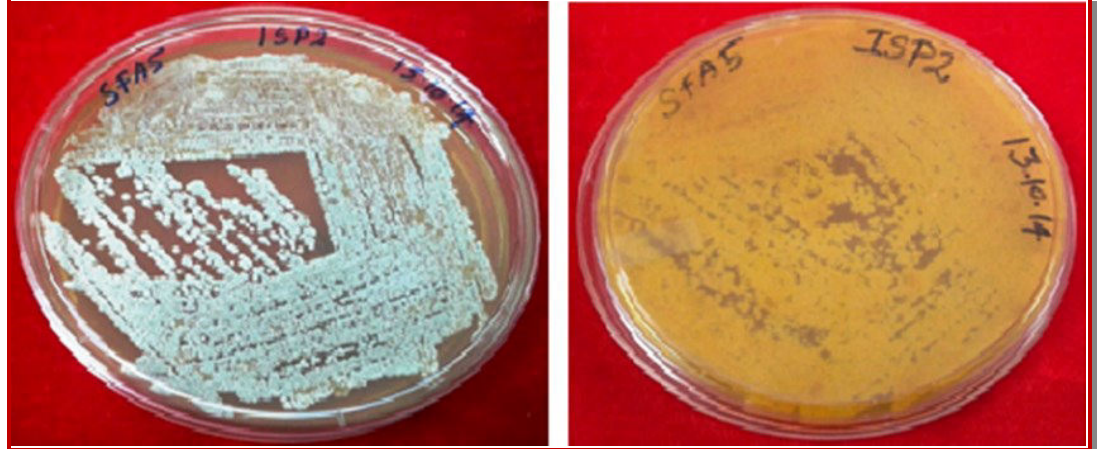
Figure 1: Morphological pattern of Streptomyces sp